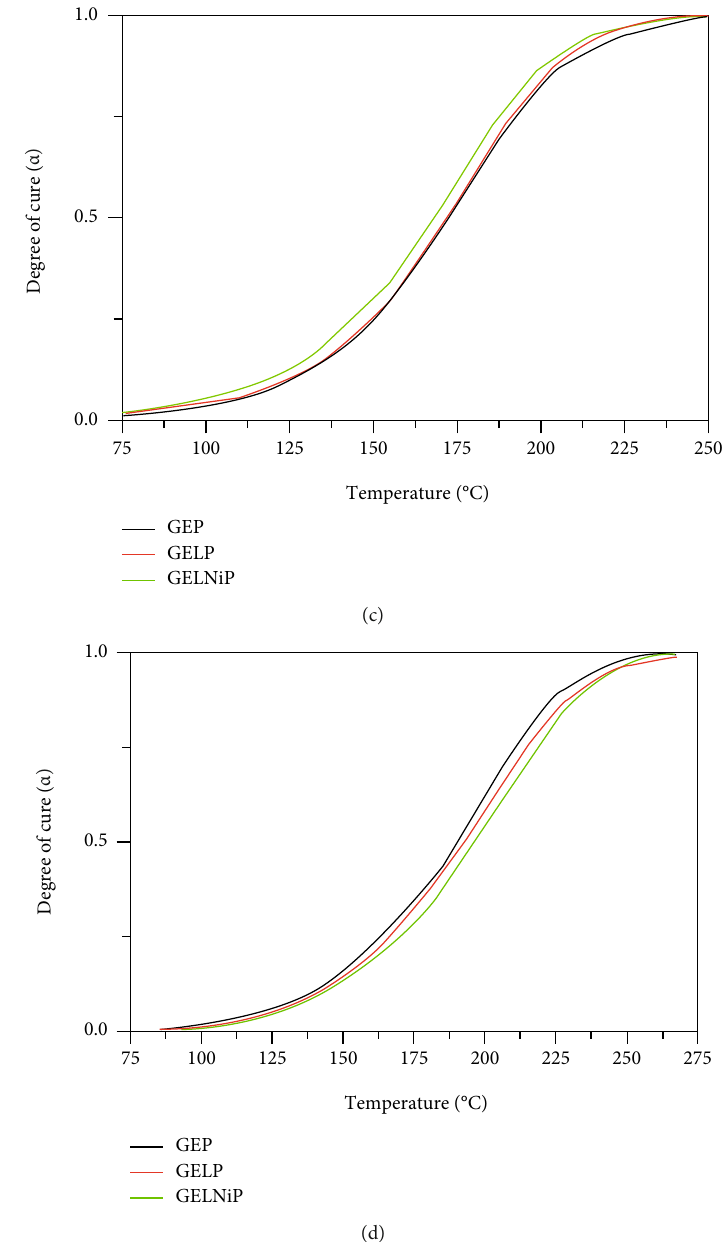
Figure 4: Conversion α as a function of temperatures for the system of GEP, GELP, and GELNiP at di ff erent heating rates of (a) 5, (b) 10, (c) 15, and (d) 20 °